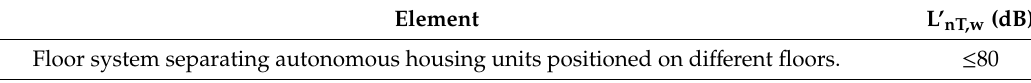
Table 5. Weighted standardized impact sound pressure level, L’ nT,w , for floor systems [15]. Element L’ nT,w